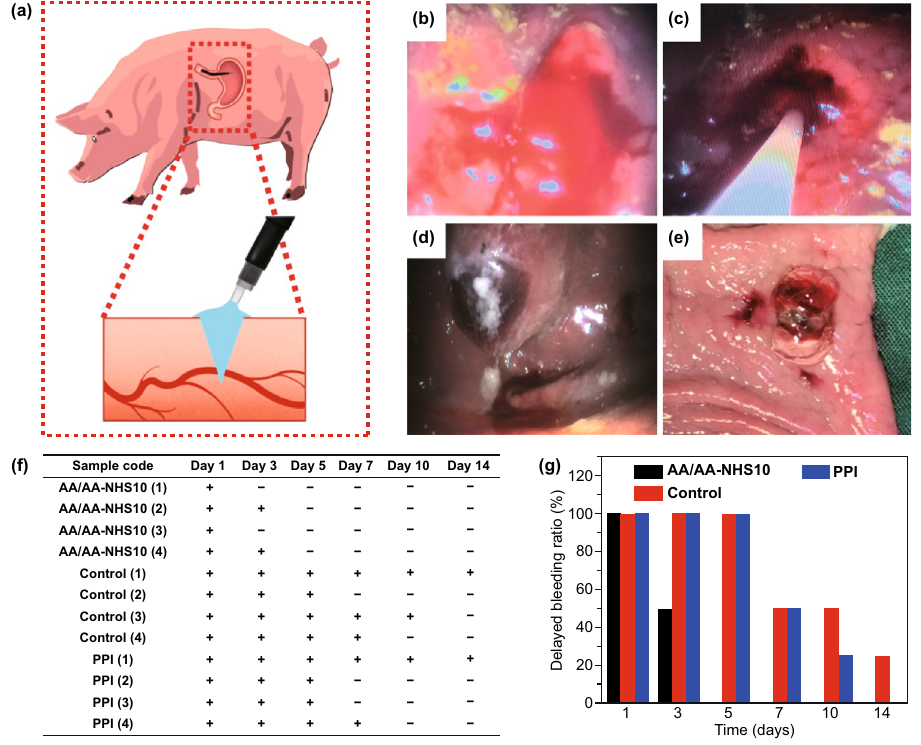
Fig. 5 a Schematic representation of the investigation protocol diagram. b Swine gastric bleeding model. c The AA/AA-NHS10 hydrogel was sprayed to the bleeding point with a spray tube through a gastroscope. The hydrogel strongly adhered to the gastric wall and stopped bleeding by forming hydrogel films d in vivo and e in vitro. f Positive ratio of fecal routine test, “ + ” indicates blood in the stool in differently treated swine, while “−” indicates swine without blood in the stool. g The delayed bleeding ratio in the different treatment groups ( n =